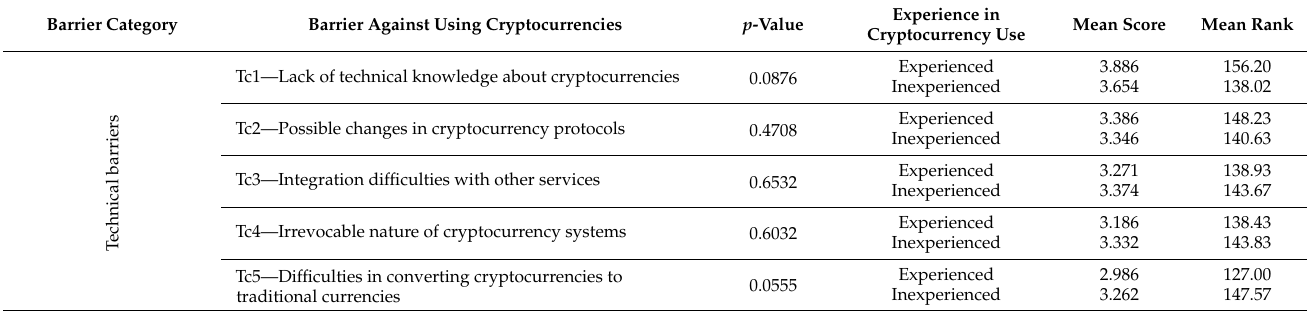
Table 5. The results of Mann–Whitney U test based on respondents’ experience in the use of